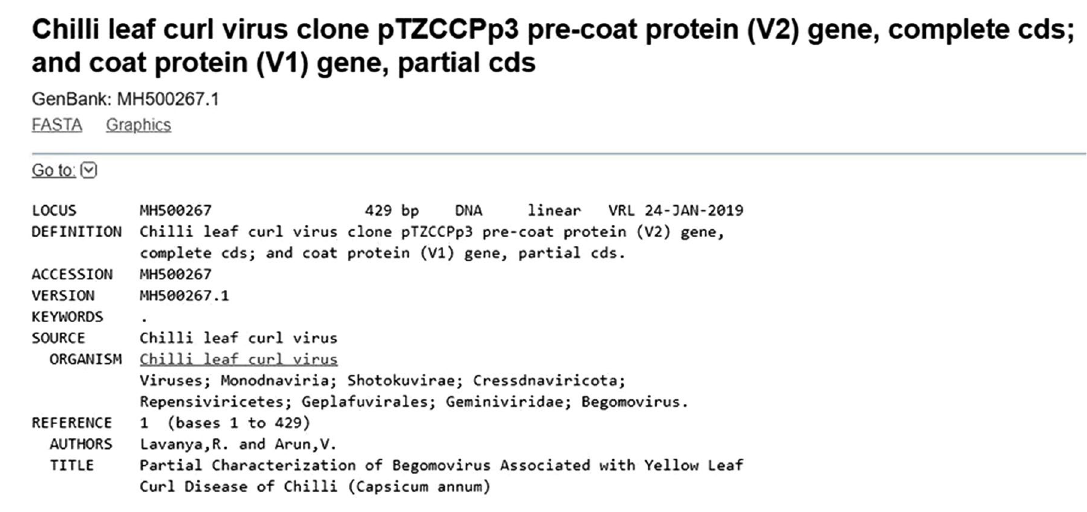
Figure 3. Chilli leaf curl viral coat protein gene (partial) obtained in this study.